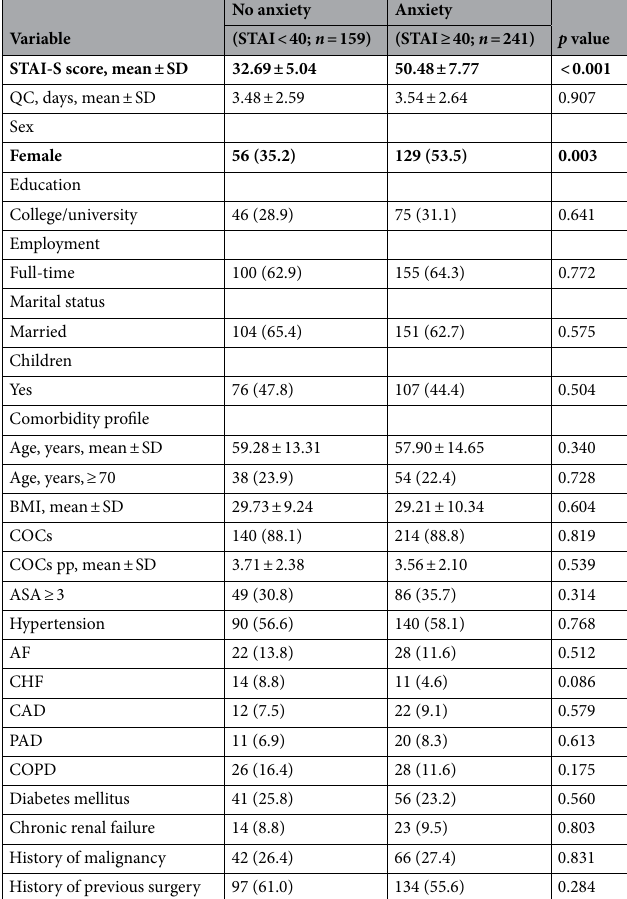
Table 1. Baseline patient characteristics ( N = 400). STAI, State-Trait Anxiety inventory (STAI-S = state anxiety); QC, questionnaire completion to surgery; BMI, body mass index in kg/m 2 ; SD, standard deviation; AF, atrial fibrillation; CHF, chronic heart failure; CAD, coronary artery disease; PAD, peripheral artery disease; COPD, chronic obstructive pulmonary disease; ASA, the American society of anesthesiologists physical status classification; COCs, comorbid conditions; pp, per patient. Numbers in bracket indicate values presented in n (%) by group unless noted otherwise. P values represent the difference between the two groups. Significant values are in bold.